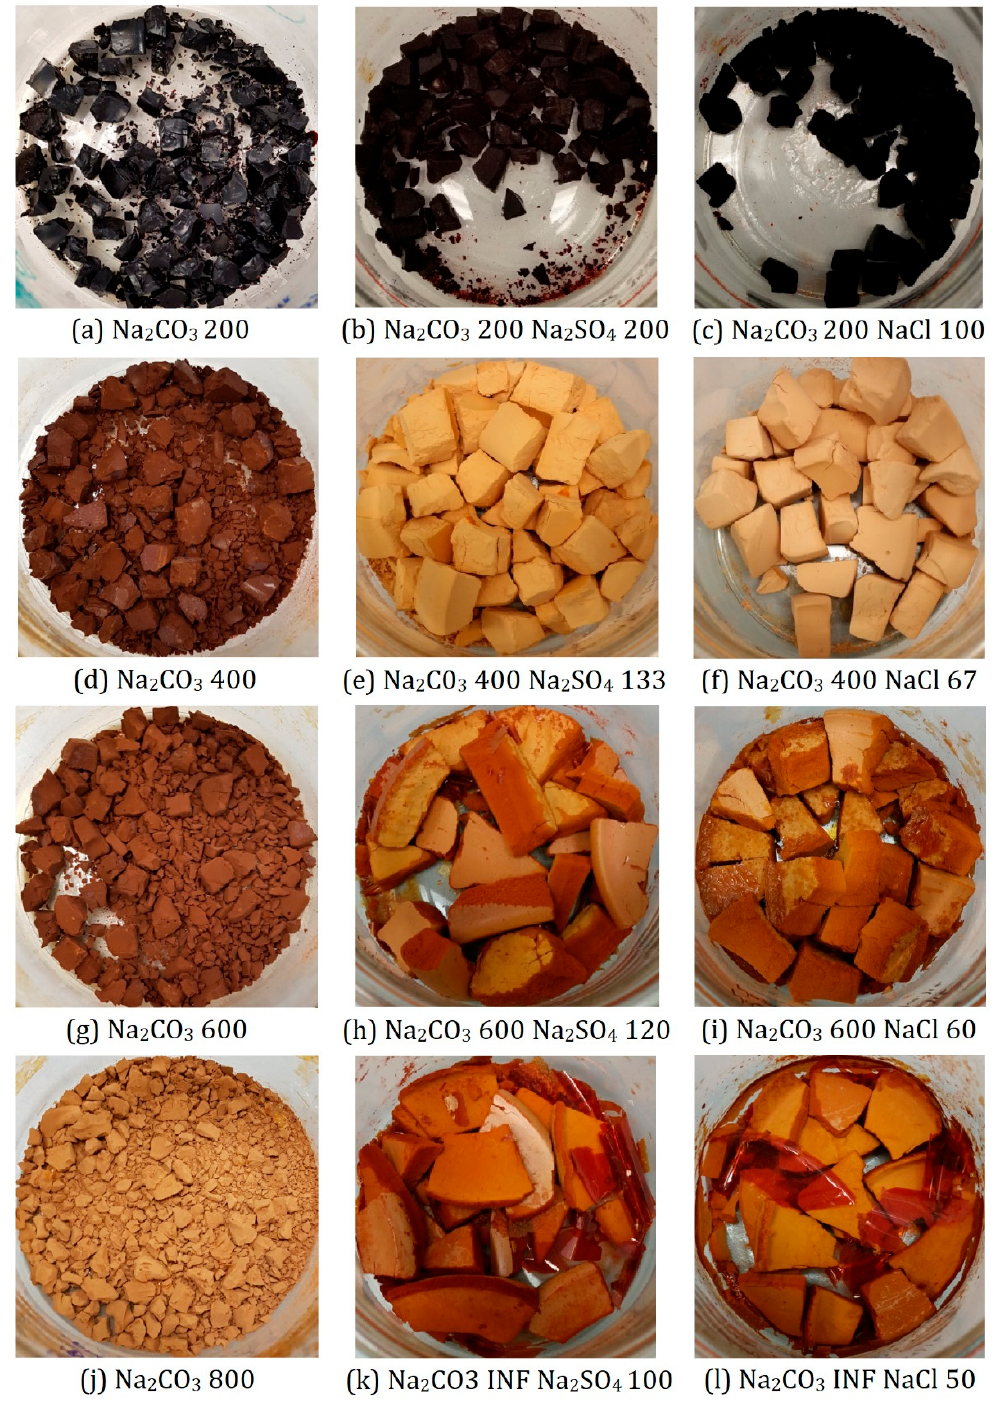
Figure 11. RF xerogels prepared with varying R/C rations of Na 2 CO 3 , Na 2 SO 4 , and NaCl.